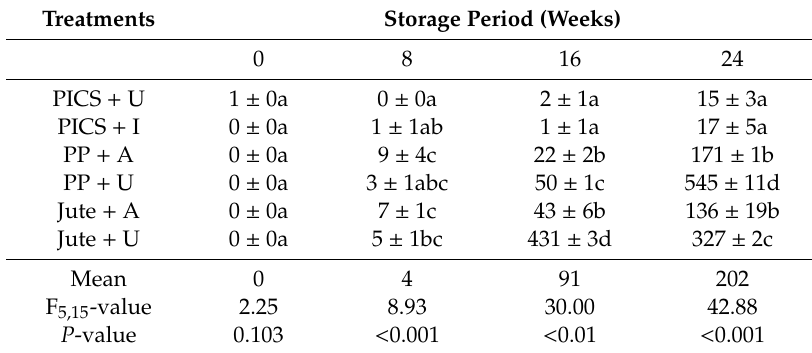
Table 3. E ff ect of treatment and storage period on total number of live adult insects in maize stored for up to 24 weeks at the Kiboko KALRO research station in Kenya. Treatments Storage Period (Weeks) 0 8 16 24 PICS + U 1 ± 0a 0 ± 0a 2 ± 1a 15 ± 3a PICS + I 0 ± 0a 1 ± 1ab 1 ± 1a 17 ± 5a PP + A 0 ± 0a 9 ± 4c 22 ± 2b 171 ± 1b PP + U 0 ± 0a 3 ± 1abc 50 ± 1c 545 ± 11d Jute + A 0 ± 0a 7 ± 1c 43 ± 6b 136 ± 19b Jute + U 0 ± 0a 5 ± 1bc 431 ± 3d 327 ± 2c Mean 0 4 91 202 F 5,15 -value 2.25 8.93 30.00 42.88 P -value 0.103 < 0.001 < 0.01 <